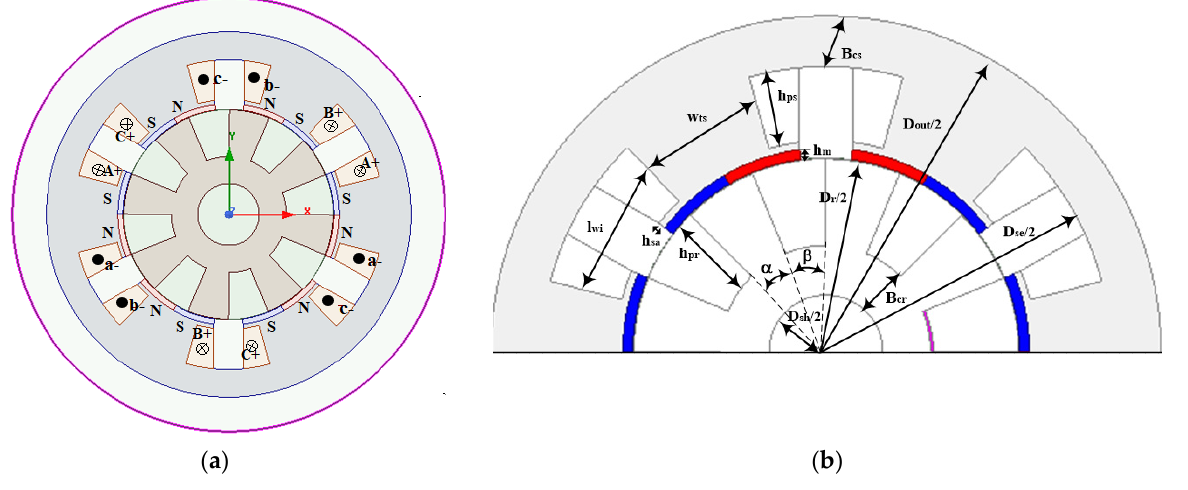
Figure 1. FRG concepts of 3-phase 6/8 pole FRG: ( a ) structural view, and ( b ) generic dimensions. Table 1. Design specifications/dimensions of RE-FRG and NRE-FRG.